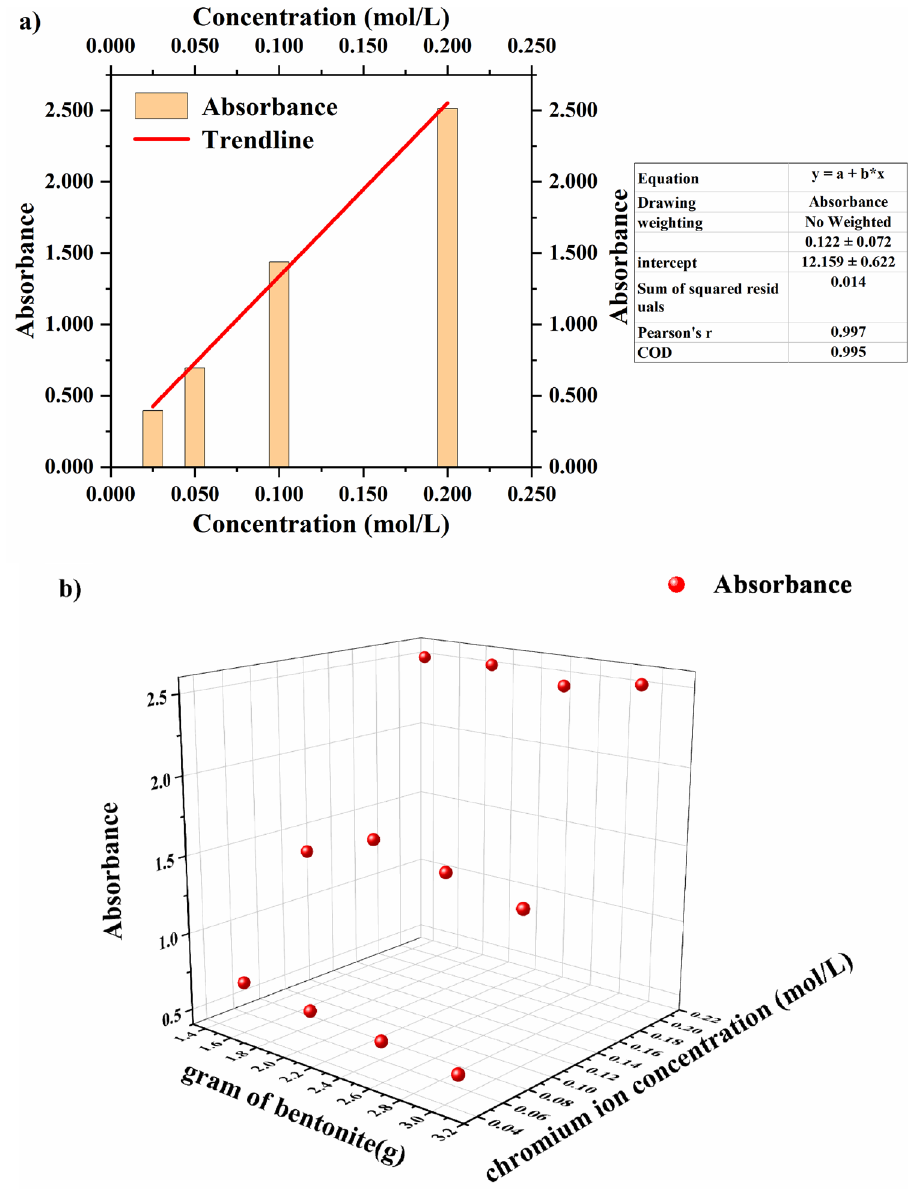
Figure 4. Diagram of the relationship between the absorbance of standard sample and chromium ion concentration ( a ). Yellow rectangles represents the sample and red straight line is the standard curve. Fitting equation and its parameters are provided in the Figure. Diagram of the relation between the absorbance, the chromium ion concentration and the weight of bentonite ( b ). Red spheres correspond to the values for absorbance of different samples. The experiments were carried out at the temperature of 293.15–298.15 K and the pressure of one